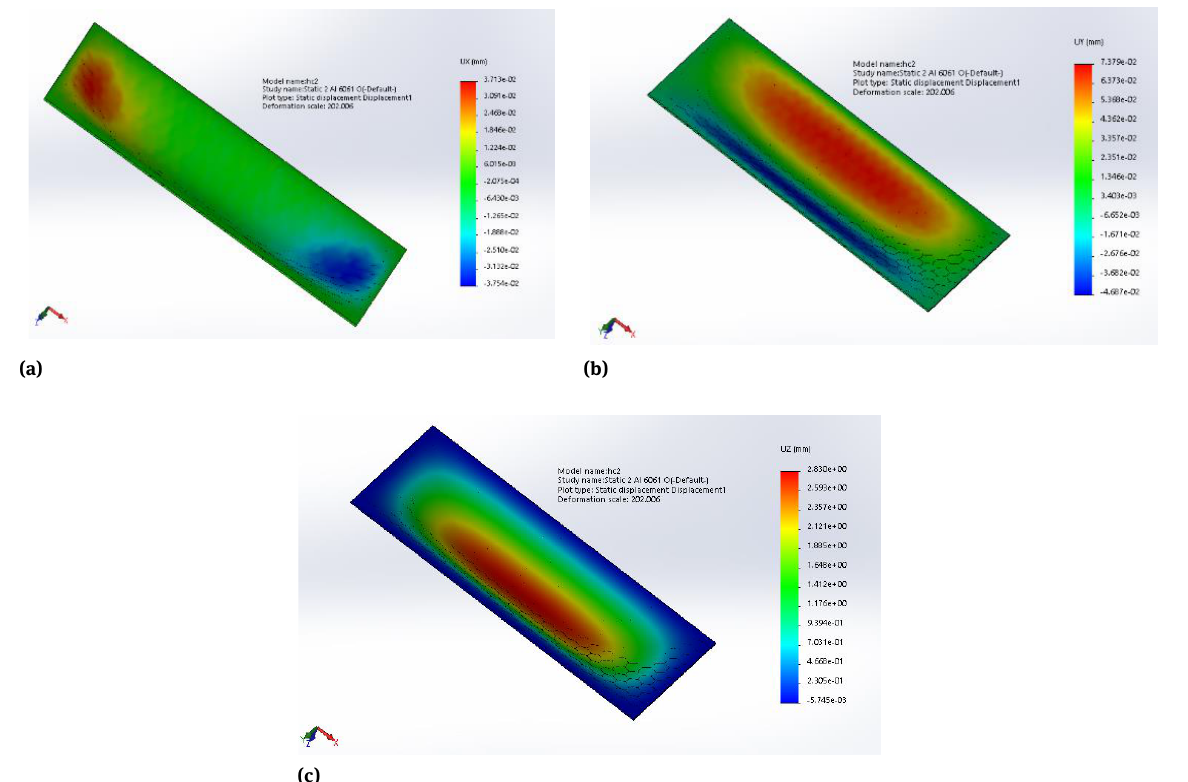
Figure 11: Displacement of the general honeycomb: (a) x-axis, (b) y-axis, (c) z-axis